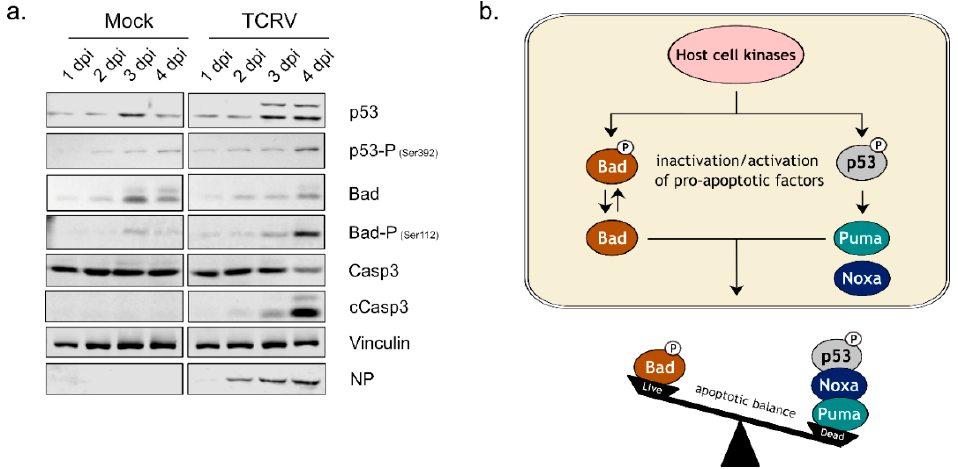
Figure 1. Regulation of pro-apoptotic factors during TCRV infection and its consequences for cell fate: ( a ) Vero76 cells were mock-infected or infected with TCRV (MOI = 0.1) and cell lysates were collected 1–4 days post-infection. Western blotting was performed to detect protein levels for p53, phosho-p53 (Serine 392), Bad, phospho-Bad (Serine 112), the full-length form of caspase 3 (Casp3) and its cleavage products (cCasp3), as indicated. Staining for Vinculin was used as a loading control and detection of NP served as a control for infection; ( b ) schematic model of the host cell factors involved in the regulation of apoptotic balance during TCRV infection. Yet unknown host cell kinases become activated in response to viral infection and subsequently mediate phosphorylation of Bad and p53. This leads to the inactivation of the pro-apoptotic factor Bad and the activation of p53, which then mediates transcription of the pro-apoptotic factors Puma and Noxa. These factors act as competing forces in the regulation of apoptotic balance within the infected cell, which late in infection favors triggering downstream apoptotic processes that ultimately lead to caspase activation and result in cell death.